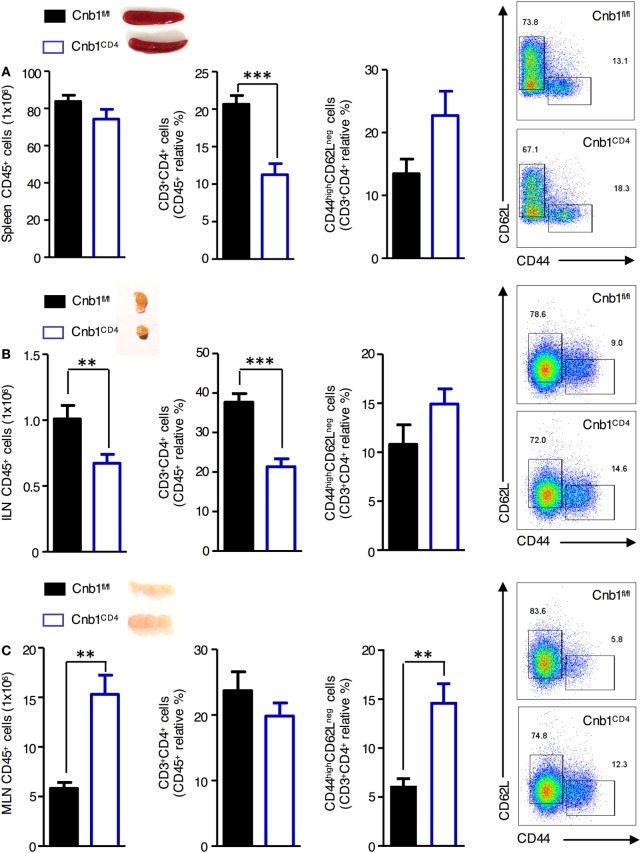
Characterization of CD4+ T cells from the spleen, inguinal lymph node (ILN), and mesenteric lymph node (MLN) of Cnb1CD4 mice. Cells were harvested from (A) the spleen, (B) ILN, and (C) MLN of Cnb1CD4 and Cnb1fl/fl mice aged 5–6 weeks. Florescence-activated cell-sorting analysis was performed to characterize the total number of CD45+ leukocytes and antigen-experienced CD44highCD62Lneg CD4+ T cells. Representative dot plots of the proportions of CD44-expressing versus CD62L-expressing cells in the CD4+ T-cell population of Cnb1CD4 and Cnb1fl/fl mice are shown. Data represent the means ± standard error of two independent experiments (n = 2–3 mice per group, per experiment). *P < 0.05; **P < 0.01; ***P < 0.005 (two-tailed, unpaired Student’s t-test).